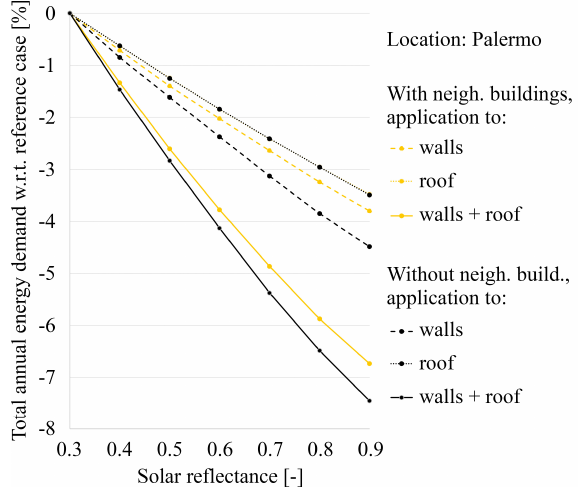
Figure 4. Influence of neighbouring buildings on the e ff ects that the "cool" cementitious tiles would have on the annual energy demand of the reference building in